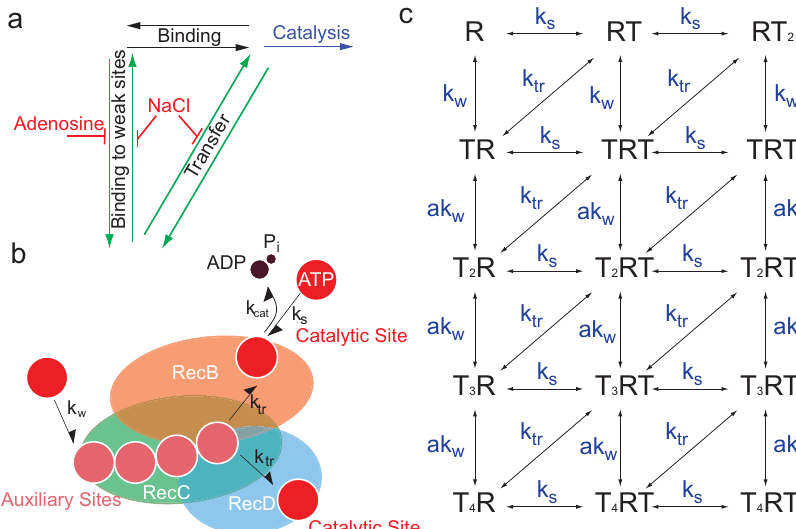
Fig. 6 Transfer of ATP from RecBCD ’ s auxiliary sites to the catalytic ones supports rapid catalysis. a . Binding of ATP to RecBCD ’ s catalytic sites can be achieved through two parallel pathways: directly from the solution (black), or through cooperative binding to the auxiliary sites followed by a transfer step (green). b . RecBCD utilizes the auxiliary binding sites as an ATP buffer, facilitating binding to the catalytic sites. The RecBCD enzyme is represented by orange, green, and blue ovals for RecB, RecC, and RecD, respectively. c . Schematic representation of the chemical intermediates in our model. R represents RecBCD, T represents an ATP molecule. T n RT m , represents n ATP molecules bound to the non-catalytic (auxiliary) sites and m ATP molecules bound to catalytic sites. Binding to RecBCD catalytic sites is uncooperative with rate k s , binding to the non-catalytic sites, k w , is cooperative (binding to the second, third or fourth non-catalytic sites is faster by the factor a ). Transfer from the non-catalytic sites to the catalytic sites occurs at a rate k tr . The reverse rates corresponding to each step are not shown, for